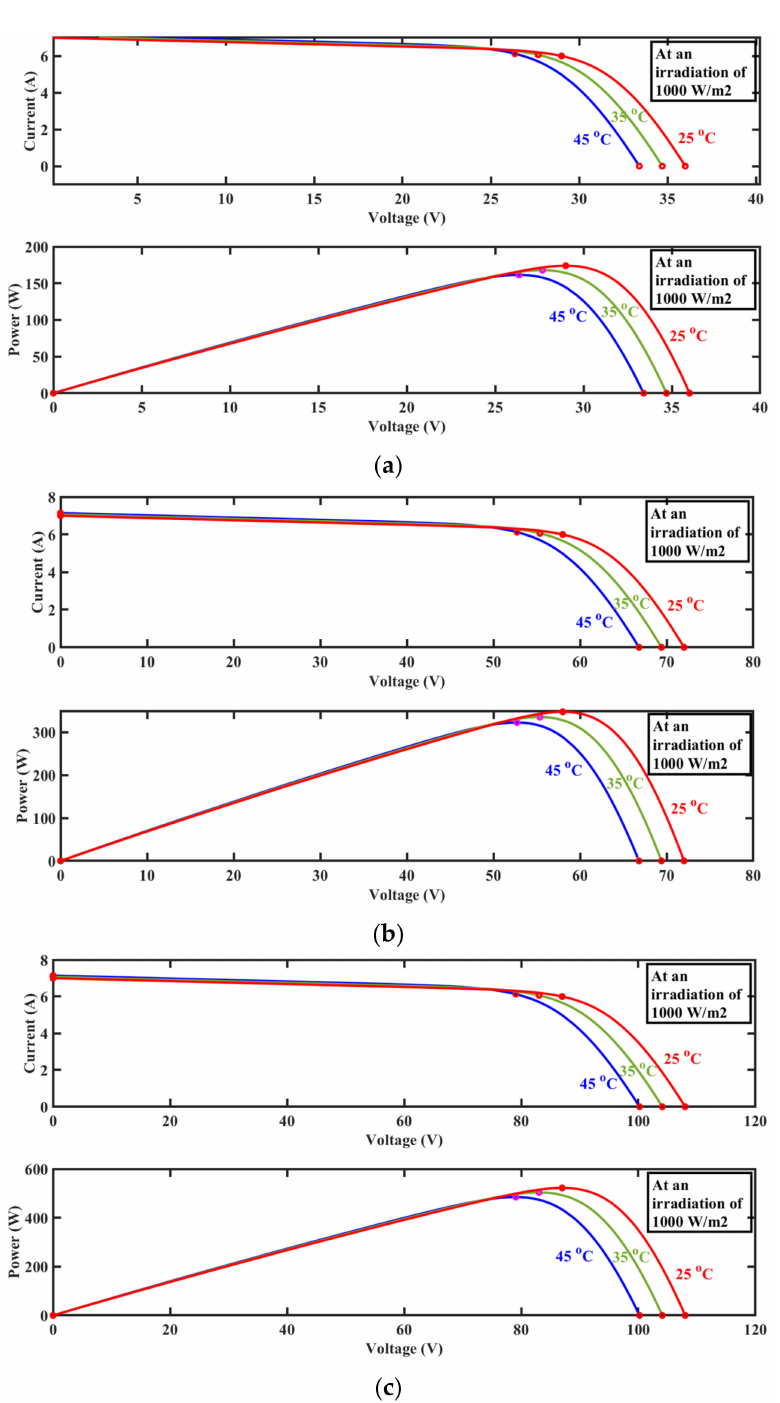
Figure 6. I-V & P-V curves at constant irradiation (1000 W/m 2 ) with variable temperatures of 25 ◦ C, 35 ◦ C and 45 ◦ C ( a ) PV 1 , ( b ) PV 2 and ( c ) PV 3